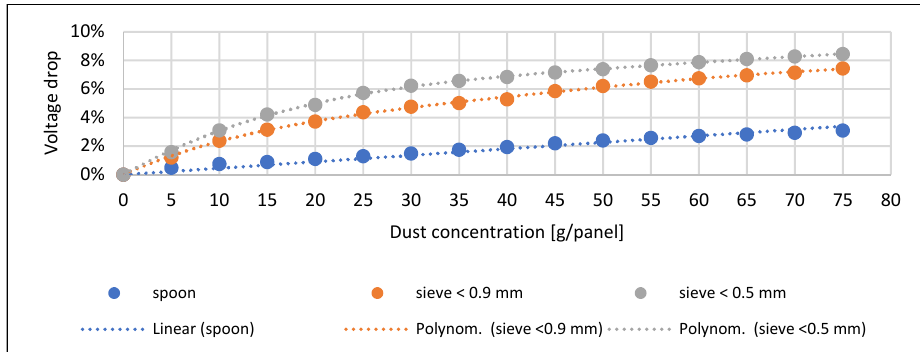
Figure 6. Power loss values as a function of the soil concentration.